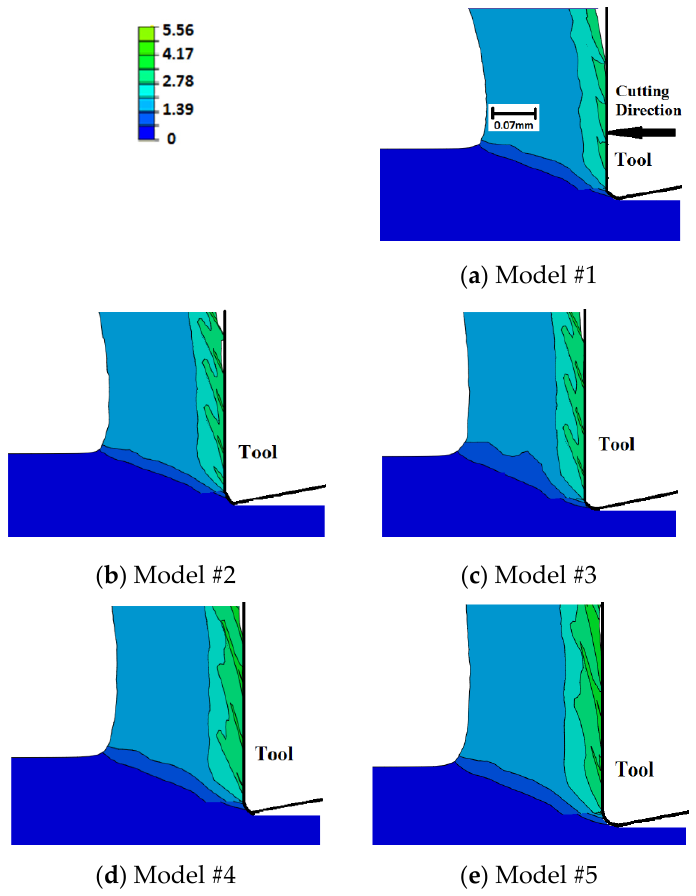
Figure 11. Equivalent plastic strains in the chip generation zone—honed tool.